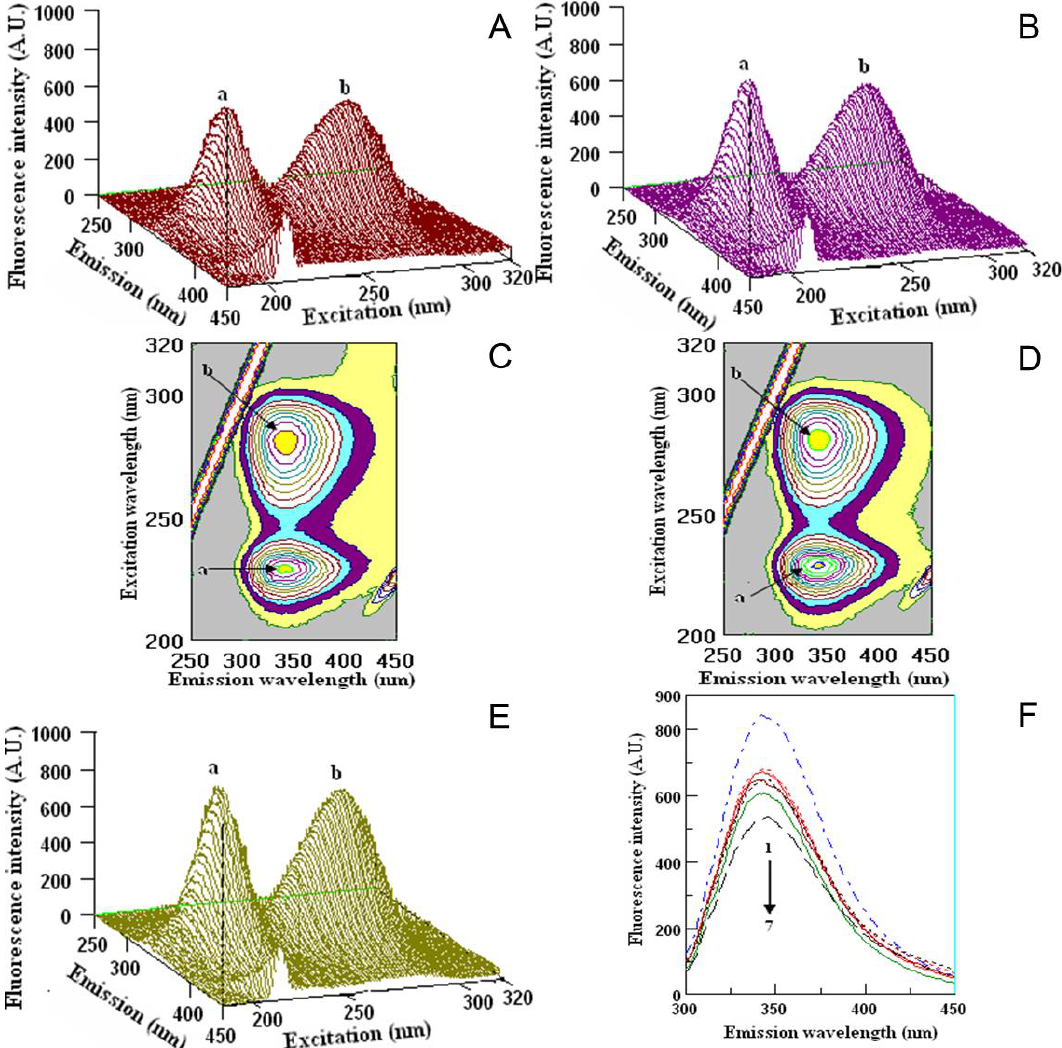
Figure 8. Fluorometric measurements in three-dimensional fluorescence analysis (3D-FL) of kiwifruit and persimmon extracts after interaction with fibrinogen. ( A , B ) 3D-FL of KH and PF after interaction with Fng; and ( C , D ) their cross images. ( E ) Fibrinogen. ( F ) Spectral data of two-dimensional fluorescence measurements (2D-FL) of fruit extracts and Fng from the top: 1, 2, 3, 4, 5, 6, 7, Fgn (FI = 834.71 A.U.), Fgn + quercetin (FI = 680.42 A.U.), Fgn + caffeic acid (FI = 671.79 A.U.), Fgn + KH (FI = 649.13 A.U.), Fgn + PF (FI = 648.29 A.U.), Fgn + catechin (FI = 606.17 A.U.), Fgn + tannic acid (FI = 538.23 A.U.). Abbreviations: KH, Actinidia (A.) deliciosa cv. Hayward; PF, Diospyros kaki Thunb. cv. Fuyu; Fgn, fibrinogen, FI, fluorescence intensity, A.U, arbitral units. The locations of peaks a and b are shown in Figures 7 and 9 (for interpretation of the references to color in this figure legend, the reader is referred to the web version of this article).